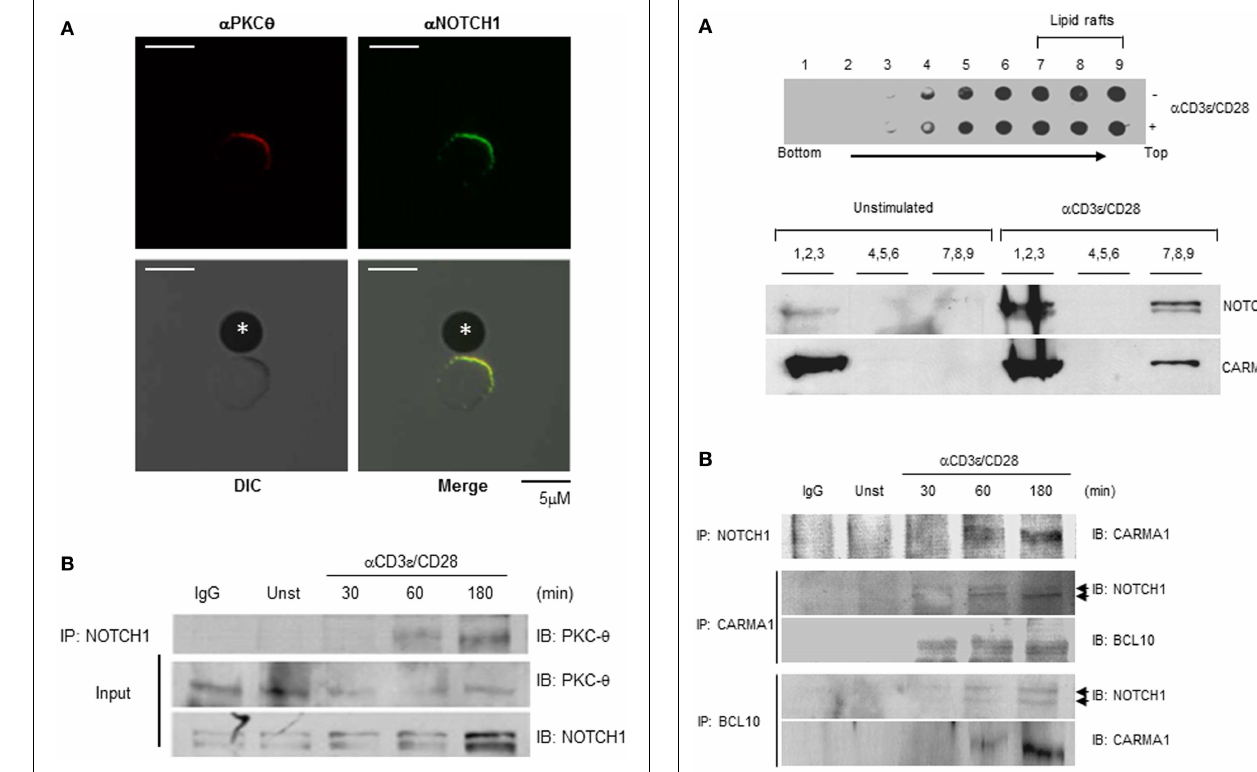
FIGURE 2 | NOTCH1 associates with PKC θ in stimulatedT cells . NOTCH1 and PKC θ co-localize and interact followingT cell stimulation. (A) Purified CD4 + T cells from C57BL/6 mice were incubated for 30min with Dynal beads pre-coated with anti-mouse CD3 ε and anti-mouse CD28 on glass slides. Cells were fixed, quenched, permeabilized, blocked, and stained with antibodies to NOTCH1 (green) and PKC θ (red). Proteins were visualized using species-specific, fluorescently conjugated secondary antibodies. *Indicates bead. (B) JurkatT cells were stimulated with plate-bound anti-human CD3 ε and anti-human CD28 for the indicated time periods, and subjected to co-immunoprecipitation with anti-NOTCH1. Immunoprecipitates (upper panel) and 1/100 of input (lower panels) were immunoblotted with anti-PKC θ and anti-NOTCH1. Data are representative of at least three independent experiments.